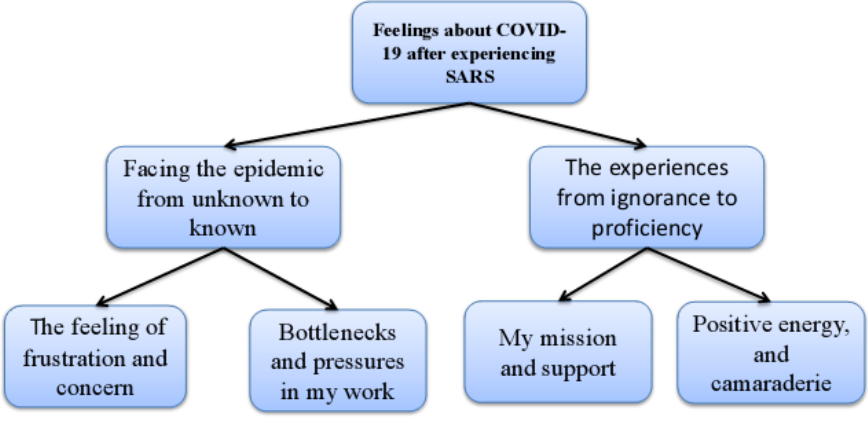
Figure 1. The themes and subthemes of study.